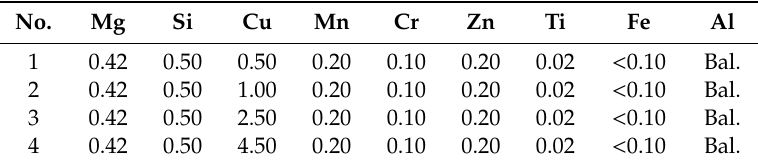
Table 1. Chemical compositions of the alloys (wt.%).